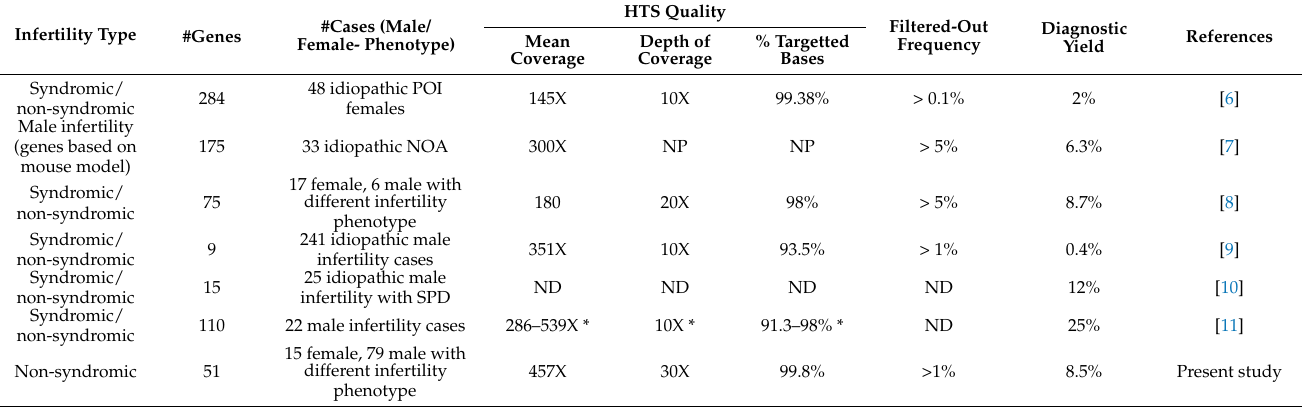
Table 5. Available gene panel publications in the infertility